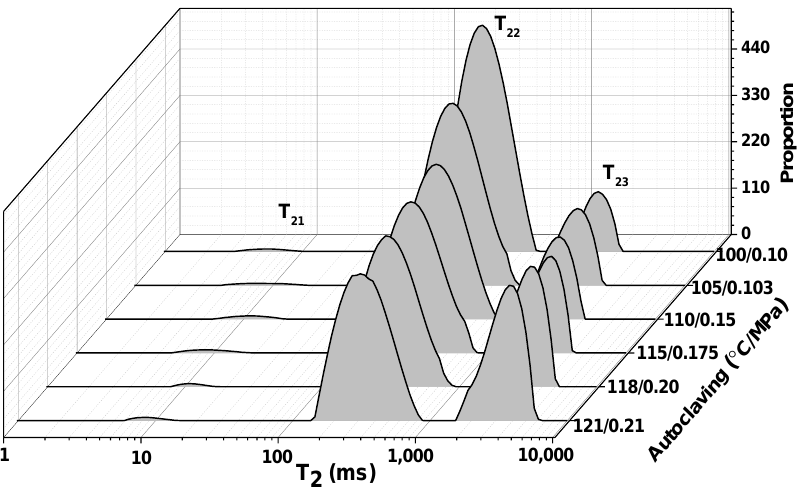
Figure 4. LF-NMR T 2 relaxation spectra of the gel samples prepared with crayfish myofibrillar protein (CMP) by different autoclaving conditions.